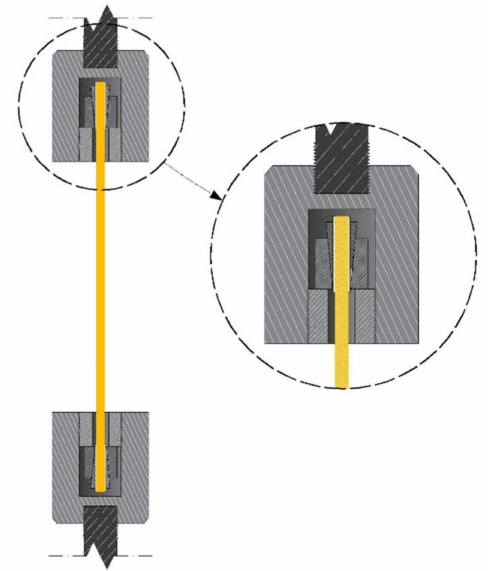
Figure 19. Test setup of the traditional anchorage specimen. The experimental force–displacement curve (Figure 20) highlights that the premature slippage (between cable and sleeve) occurred at a load of ≈ 60 kN. Displacements in Figure 20 are those acquired by the testing machine (MTS).